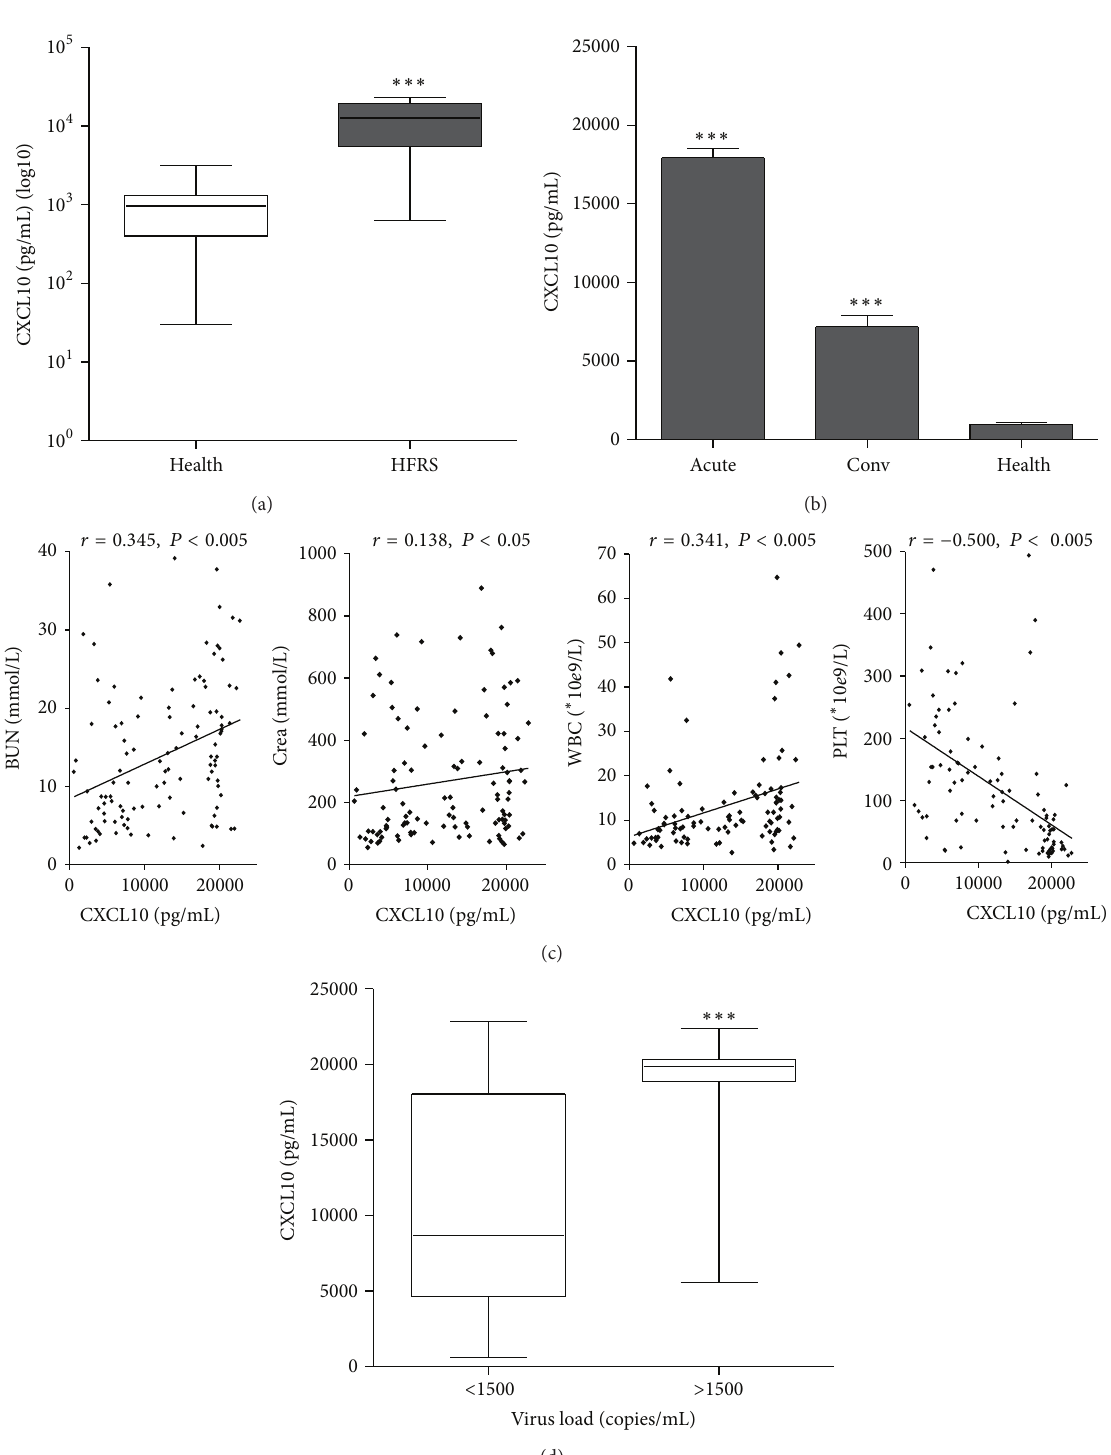
Figure 1: Increased CXCL10 level in HFRS patients’ sera is positively correlated with HFRS severity. (a) Box plot displaying the minimum, 25th, 50th, 75th, and maximum percentiles of CXCL10 levels. Comparison of serum CXCL10 contents between healthy donors (NC) and HFRS patients. Data were means ± SE (NC, 𝑛 = 36 ; HFRS, 𝑛 = 121 ). ∗∗∗ 𝑃 < 0.001 , HFRS patients versus healthy donors. (b) Contents of CXCL10 in acute and convalescent phases in HFRS patients. Data were means ± SE (NC, 𝑛 = 36 ; HFRS, 𝑛 = 121 ). ∗∗∗ 𝑃 < 0.001 , acute or convalescent phase versus NC. (c) Serum CXCL10 levels were positively correlated with blood urea nitrogen (BUN), creatinine (Crea), and white blood cells (WBC) in the entire group of subjects while negatively correlated with platelet count (PLT). The 𝑟 and 𝑃 values were indicated in the graphs. (d) Serum CXCL10 levels were in relation to the plasma viral loads. Patients with viral loads > 1500 copies/mL had significant higher CXCL10 levels than those with viral loads < 1500 copies/mL ( ∗∗∗ 𝑃 < 0.001